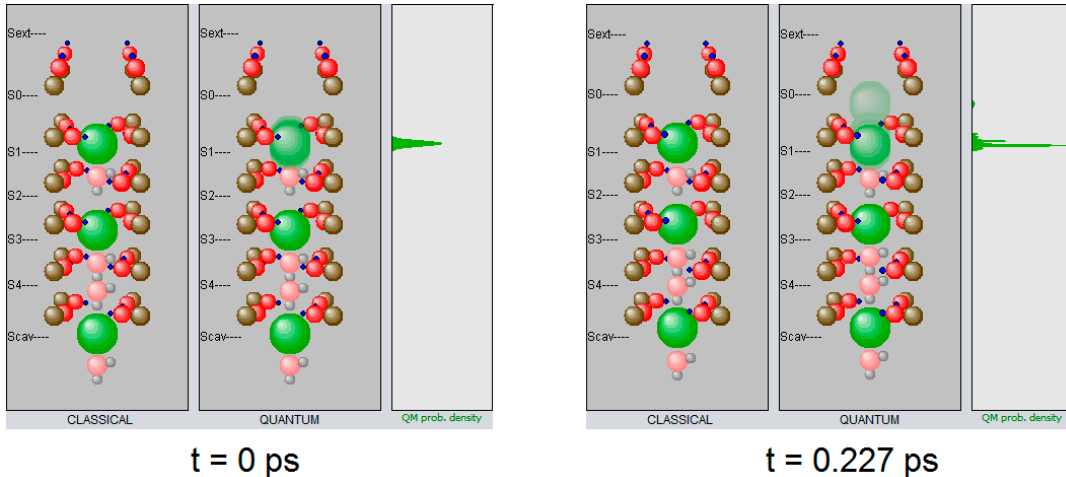
Figure 6. Configuration in the selectivity filter for time t = 0, when the evolution was started, and for time t = 0.227 ps, which is a typical coherence time for this configuration (see Figure 4). In each picture the classical case is on the left, the case with the topmost K + ion calculated as a quantum mechanical wave packet in the middle, and the quantum mechanical probability distribution of the ion on the right. (The quantum mechanically calculated K + is shown as partly overlapping semi-transparent spheres at di ff erent positions and the transparency scales inversely with the probability density at that position.) At t = 0 ps, the quantum mechanical ion has a certain spread due to the Heisenberg uncertainty. At t = 0.227 ps, this wave packet has gained a noticeable extension into the site S0. (An animation showing the entire evolution is available as supplementary material).